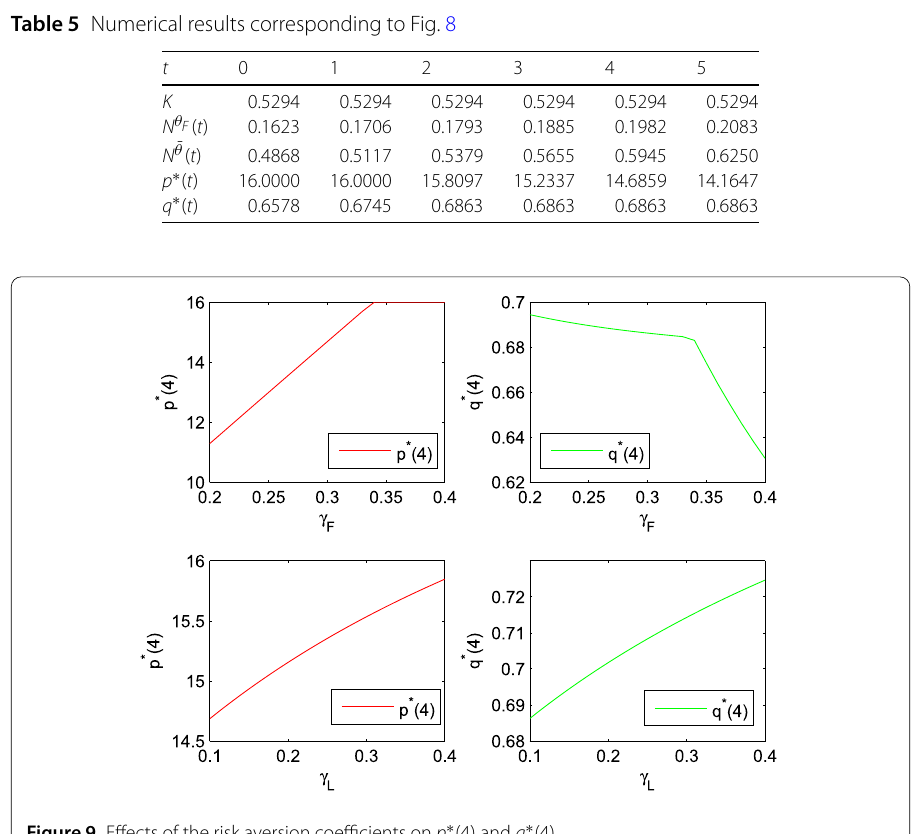
Figure 9 Effects of the risk aversion coefficients on p ∗ (4) and q ∗ (4)